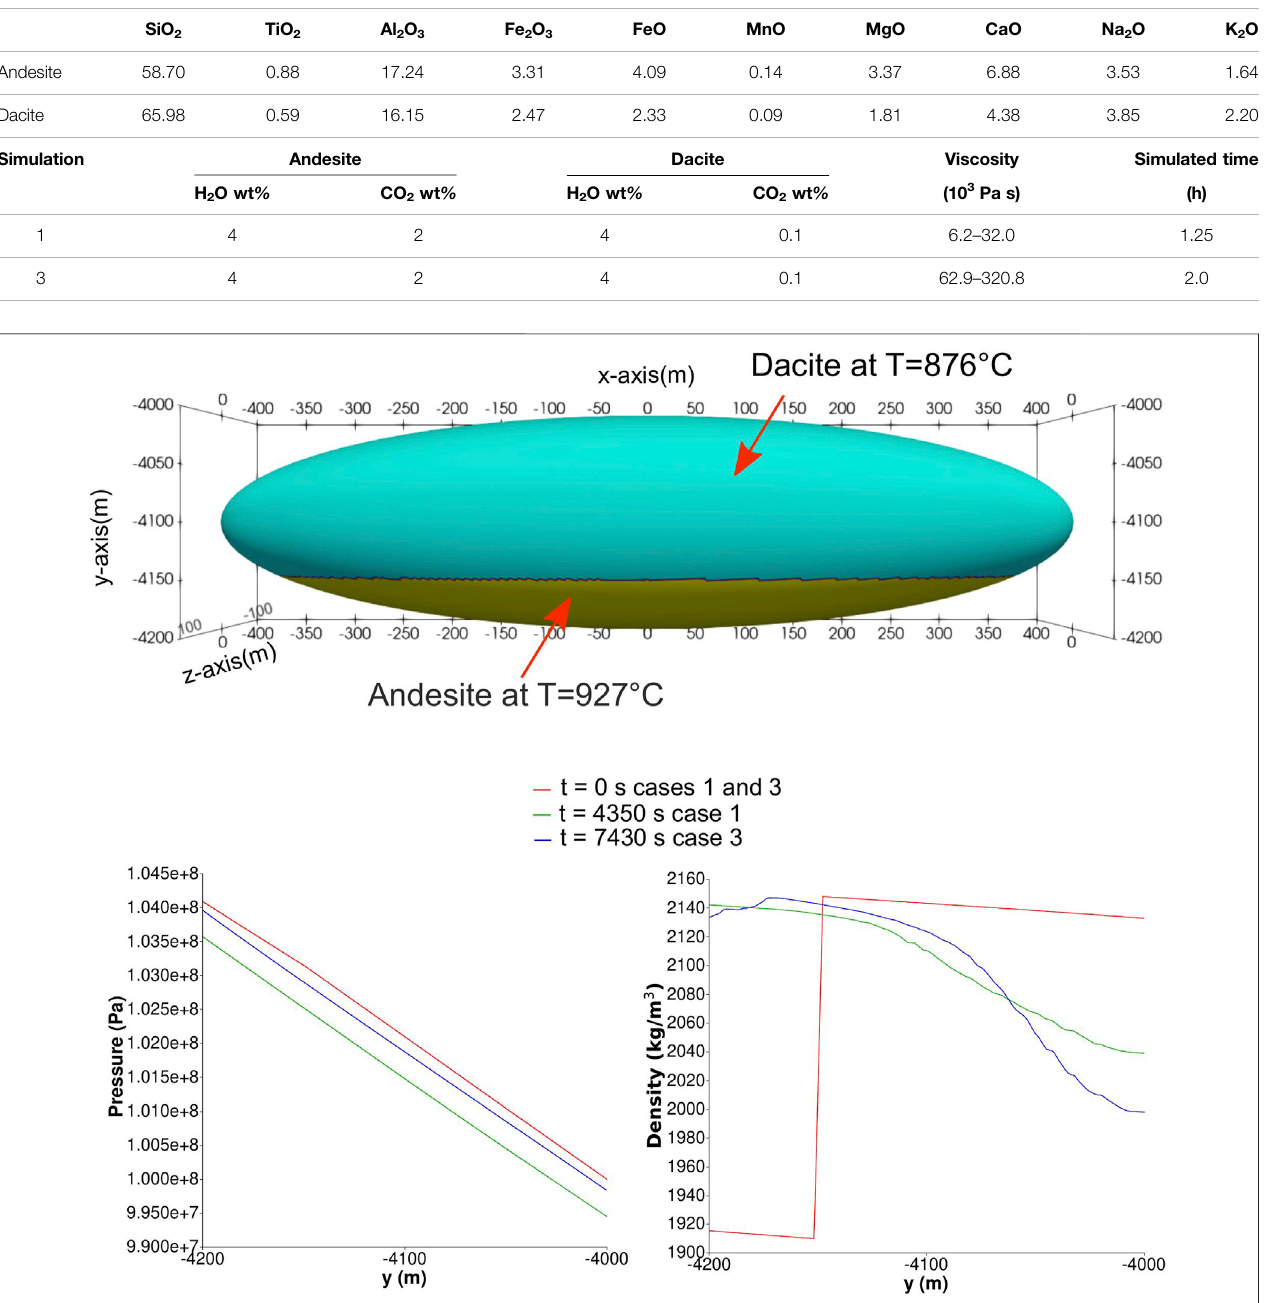
FIGURE 1 | Simulations setup and pro fi les of pressure and density along chamber axis ( x (cid:2) 0, z (cid:2) 0).